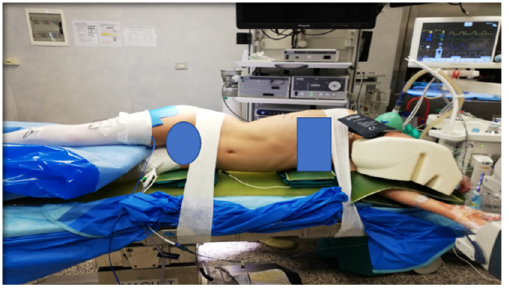
Figure 1. Position of the patient on the surgical table: the patient is positioned in left lateral 90° decubitus with the right side up. Appropriate soft gel pads are placed under the left shoulder and pelvis, in order to obtain a suspension of the spinal column with attenuation of the convexity. The patient is then secured with tape.